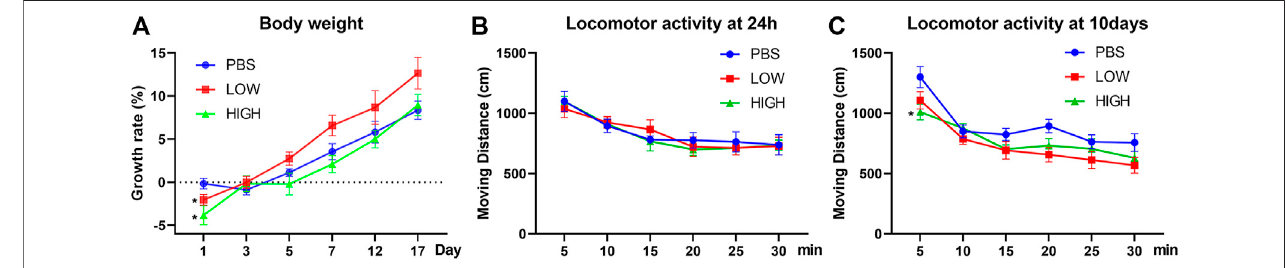
FIGURE1| EffectsofHCQ onbodyweight andlocomotoractivity. (A) Therateofincreaseinbodyweight ofmice inthelasting group. (B) Thelocomotoractivityof miceintheimmediategroup. (C) Thelocomotoractivityofmiceinthelastinggroup( n (cid:1) seventoeightforeachsubgroup;repeatedmeasurestwo-wayANOVA,* p < 0.05 compared with the PBS group).